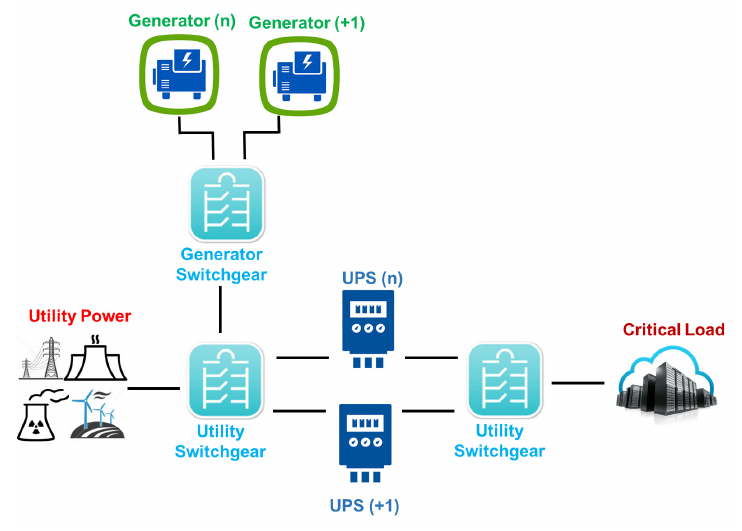
Figure 2. Tier II data center power subsystem.